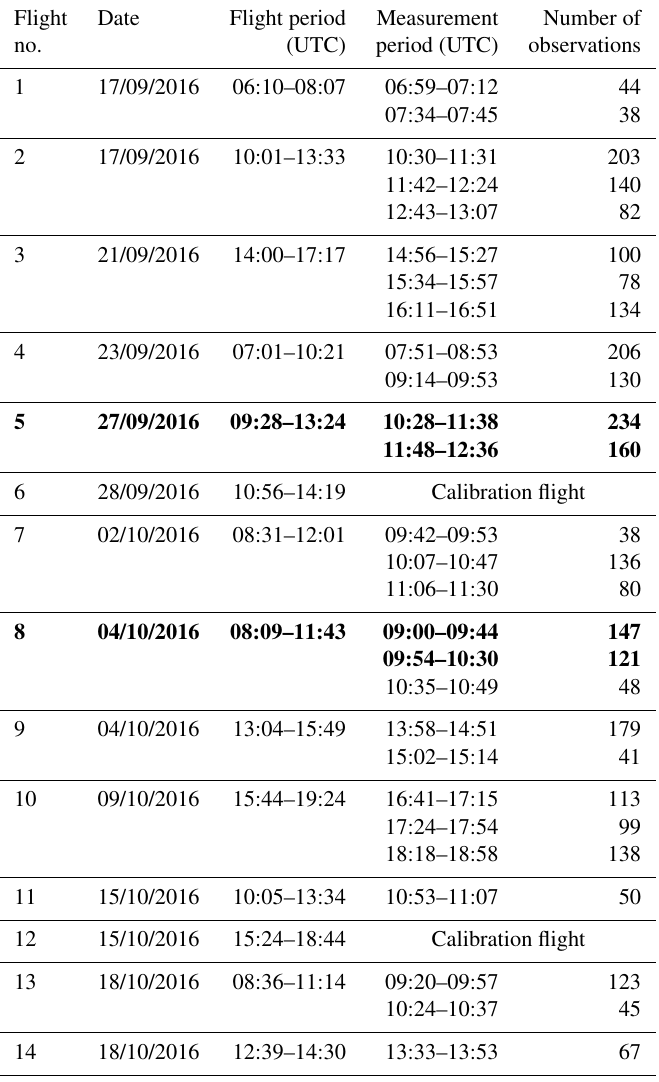
Table 1. Overview of the research flights of the Falcon aircraft conducted in the frame of the NAWDEX campaign and the wind scenes performed with the A2D. The flights on 27 September and 4 October 2016 discussed in the present work are printed in bold. The two flights on 28 September and 15 October 2016 were dedicated to response calibrations of the Rayleigh and Mie channel (see Sect. 3.1), while the first two and the last two flights on 17 September and 18 October 2016 were transfer flights between Oberpfaffenhofen, Germany, and the air base in Keflavík,